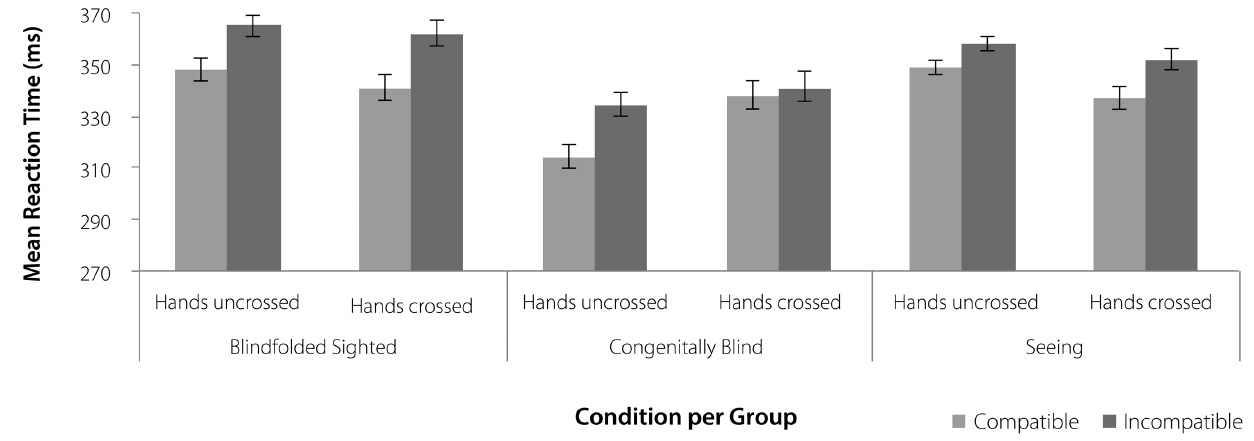
Figure 2. Results. Mean reaction time as a function of group (Blindfolded-Sighted, Congenitally-Blind, Seeing), condition (hands uncrossed, hands crossed) and spatial stimulus–response compatibility (Compatible, Incompatible). Error bars depict the standard error of the mean difference.